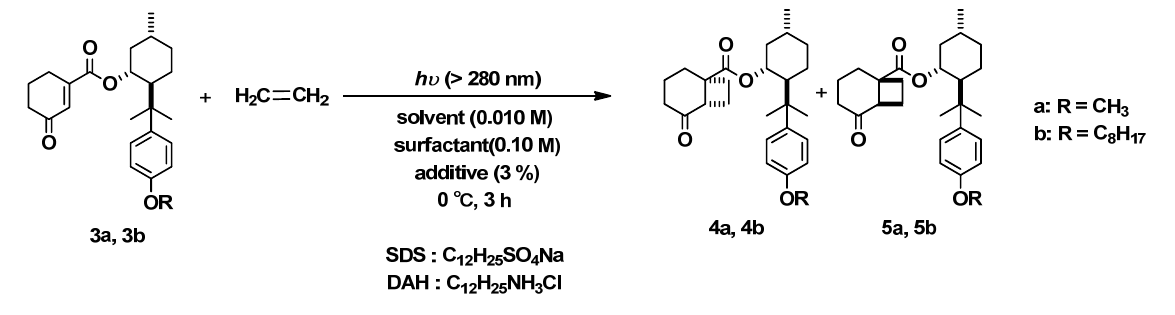
Table 1. Diastereoselective [2+2] photocycloaddition of 3a , b with ethylene a